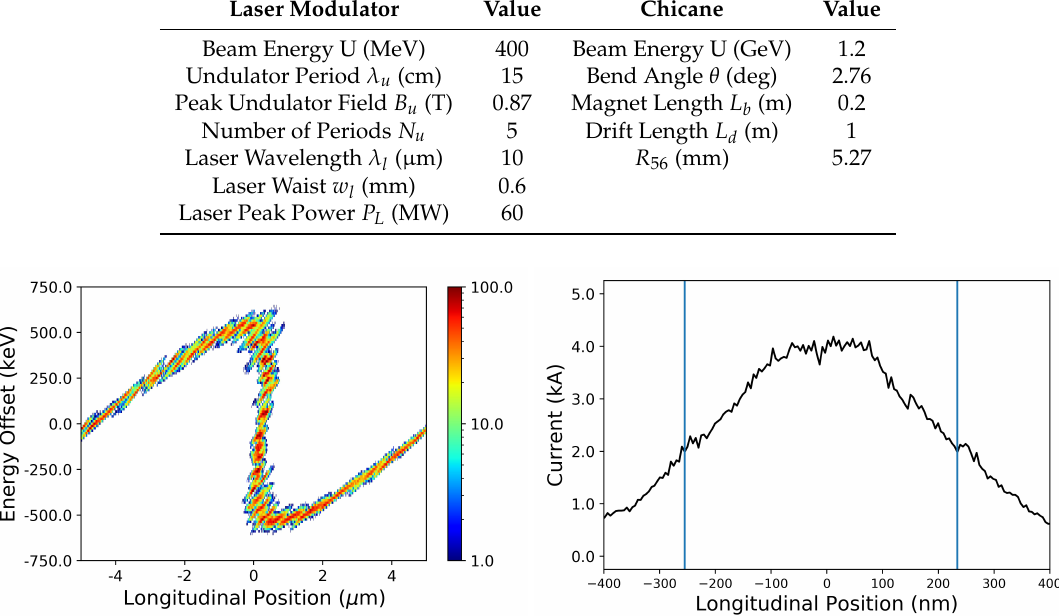
Figure 9. Optimal modulation amplitude and compression from the peak current contour with A = 19.13 and B = 0.0635. On the left, the longitudinal phase space of one microbunch shown is at 1.2 GeV, nominally at the entrance of the undulator. On the right, the associated current profile is plotted with the blue vertical lines indicating where the current falls to half of its peak value. In both plots, the beam head is to the